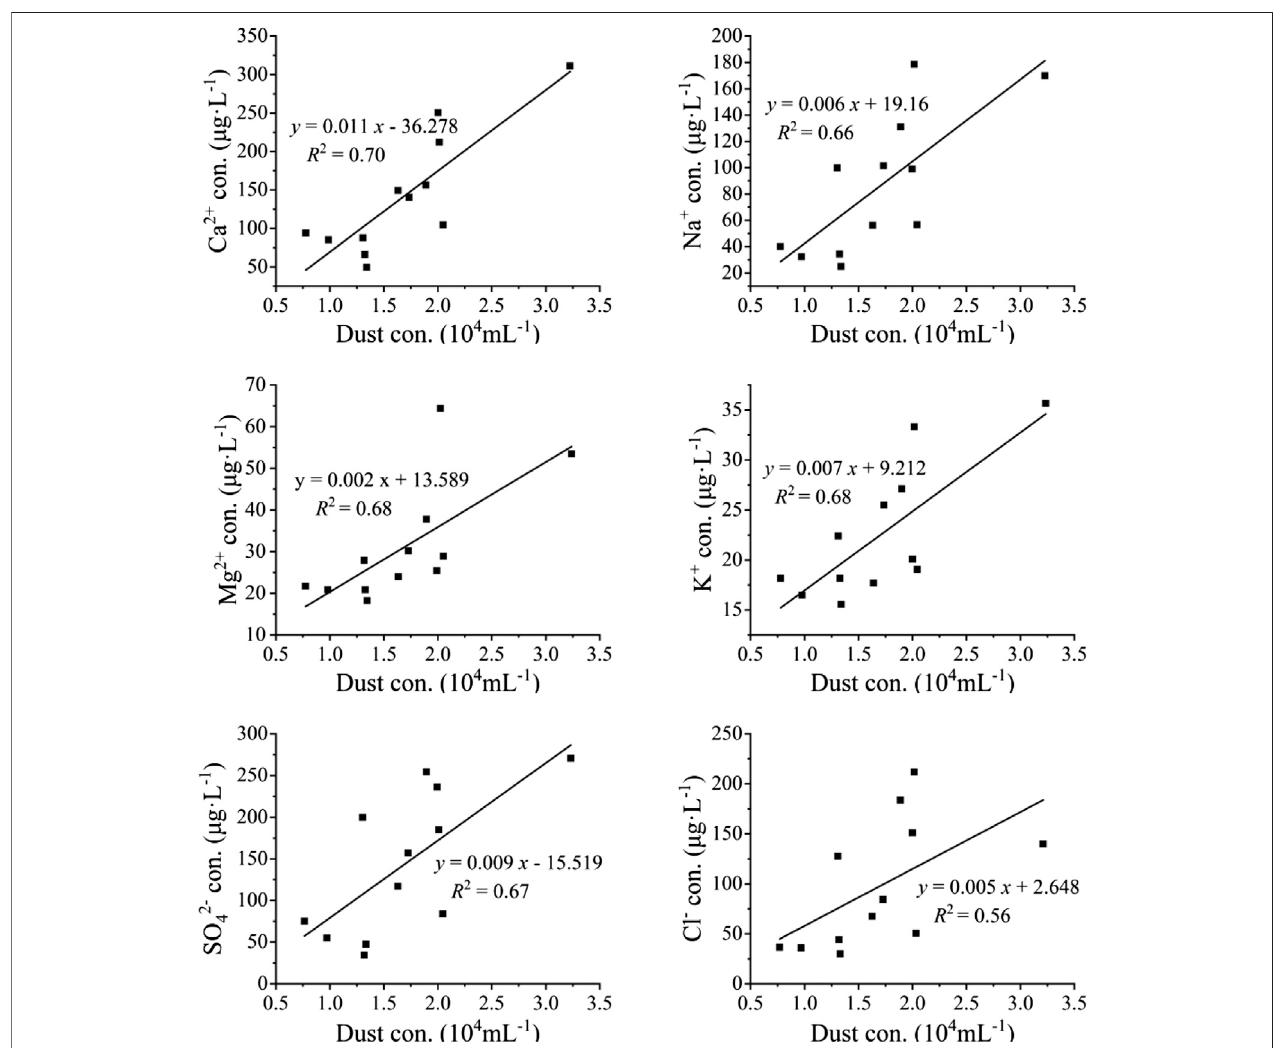
FIGURE 4 | Relationships between concentrations of dust and each of the major ions in snow, with linear models fi tted.